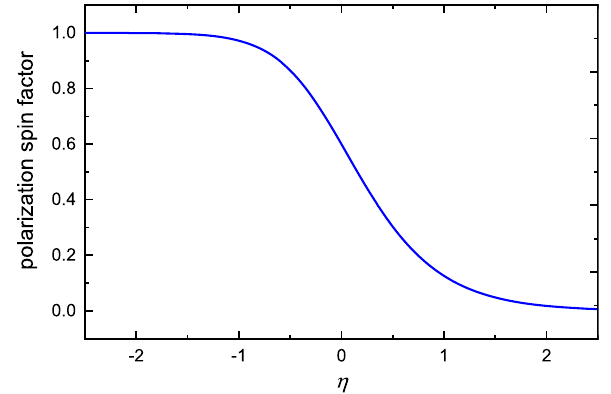
Fig. 1 The polarization transfer factor T (η) versus rapidity η of the process qg → qg . The solid curve represents the longitudinal polariza- tion transfer factor of the process Δ g → Δ q . The polarization transfer factor for T Δ q → Δ q (η) = 1 is not presented in the